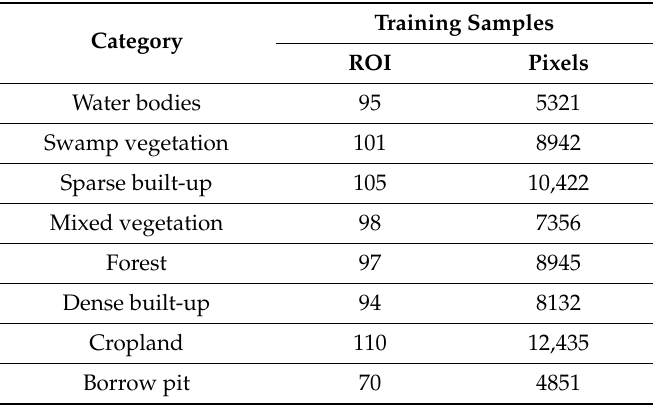
Table 1. Samples of the training